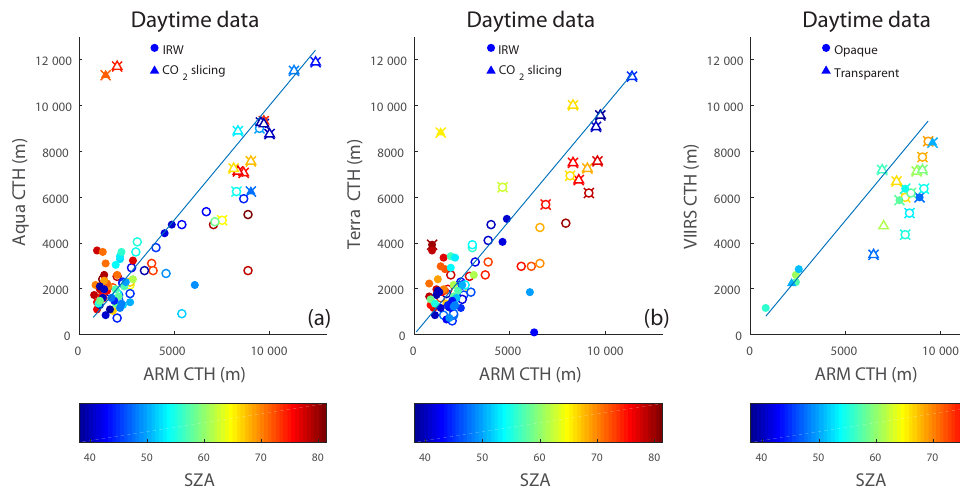
Figure 2. The same as Fig. 1 except for daytime cases. Table 2. Same as in Table 1 except for daytime cases. Satellite CTH- No. of Median